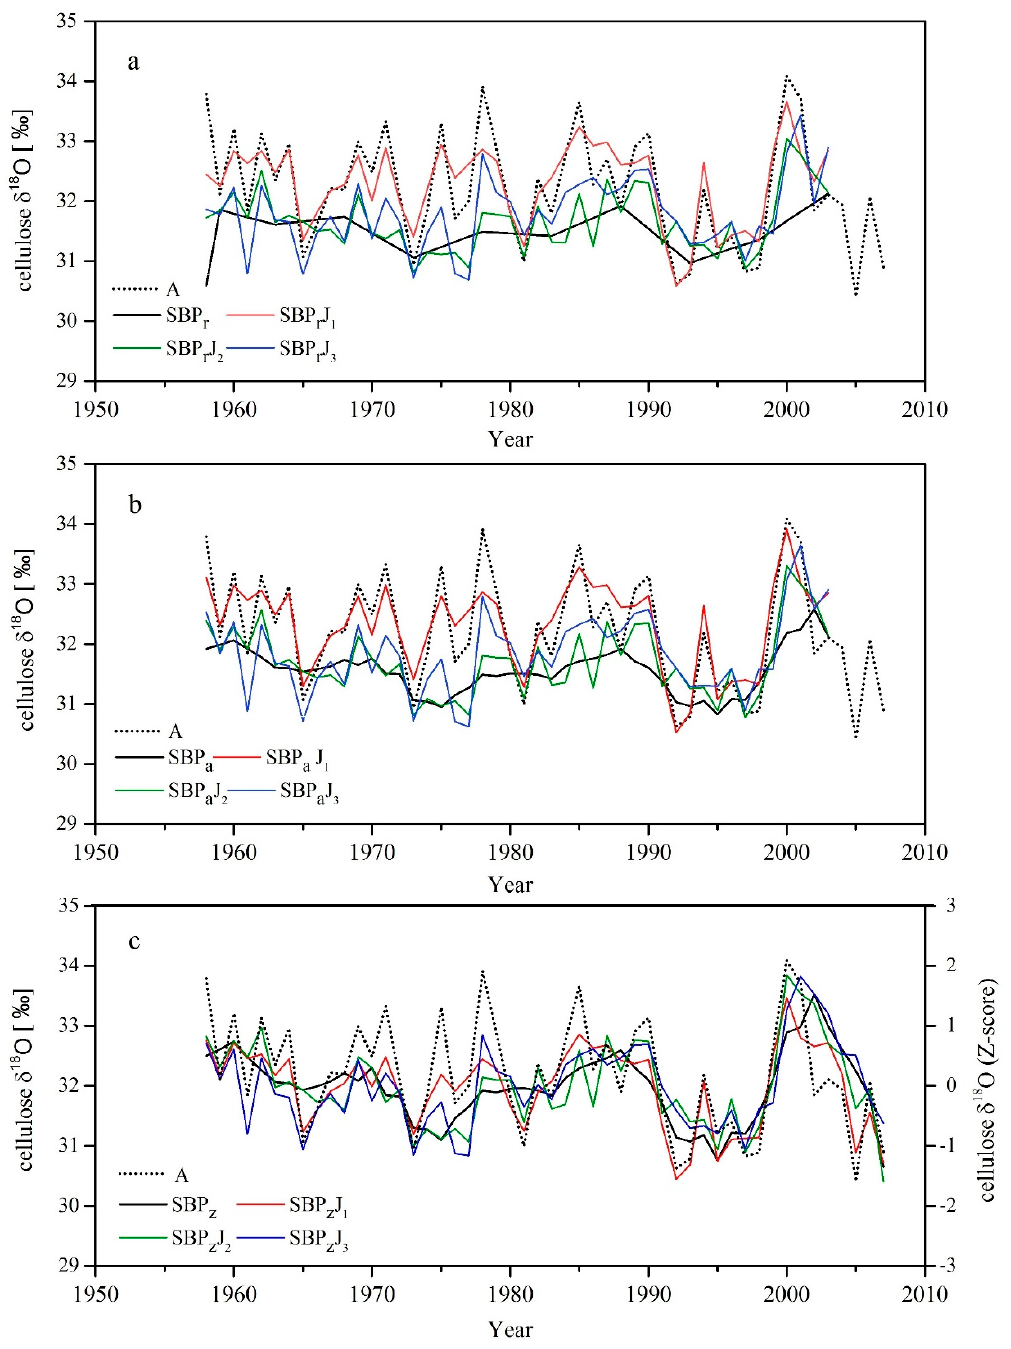
Figure 8. Comparison between the inter-annual δ 18 O variations of the mean annually resolved chronology A and the mixed δ 18 O chronologies of ( a ) SBP r includes SBP r J 1 , SBP r J 2 , and SBP r J 3 , ( b ) SBP a includes SBP a J 1 , SBP a J 2 , and SBP a J 3 ; ( c ) SBP z includes SBP z J 1 , SBP z J 2 , and SBP z J 3 over the period 1958 to 2007. In chart © , the scale of the primary (left) vertical axis reflects the values of the A chronology. A highly significant correlation between mixed SBP r and A (r SBPrJ1/A = 0.85, r SBPrJ2/A = 0.75 , r (cid:2903)(cid:2886)(cid:2900)(cid:2928)(cid:2894)(cid:2871) (cid:2885)⁄ = 0.75; p < 0.01) compared to a less significant correlation between SBP r and A (r SBP r /A = 0.46;